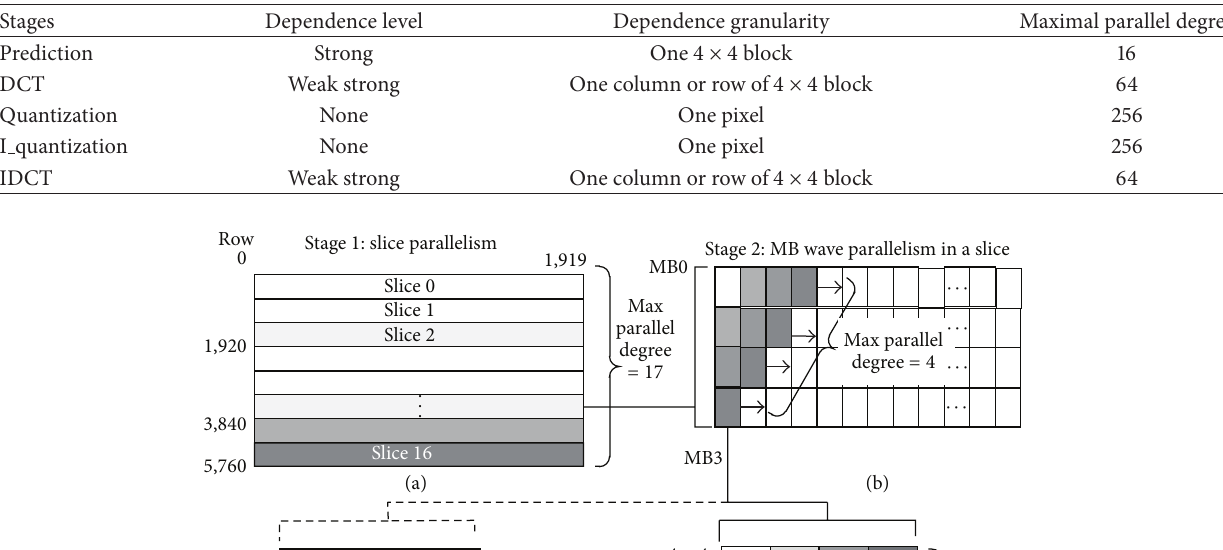
Table 1: Characteristics of five stages.